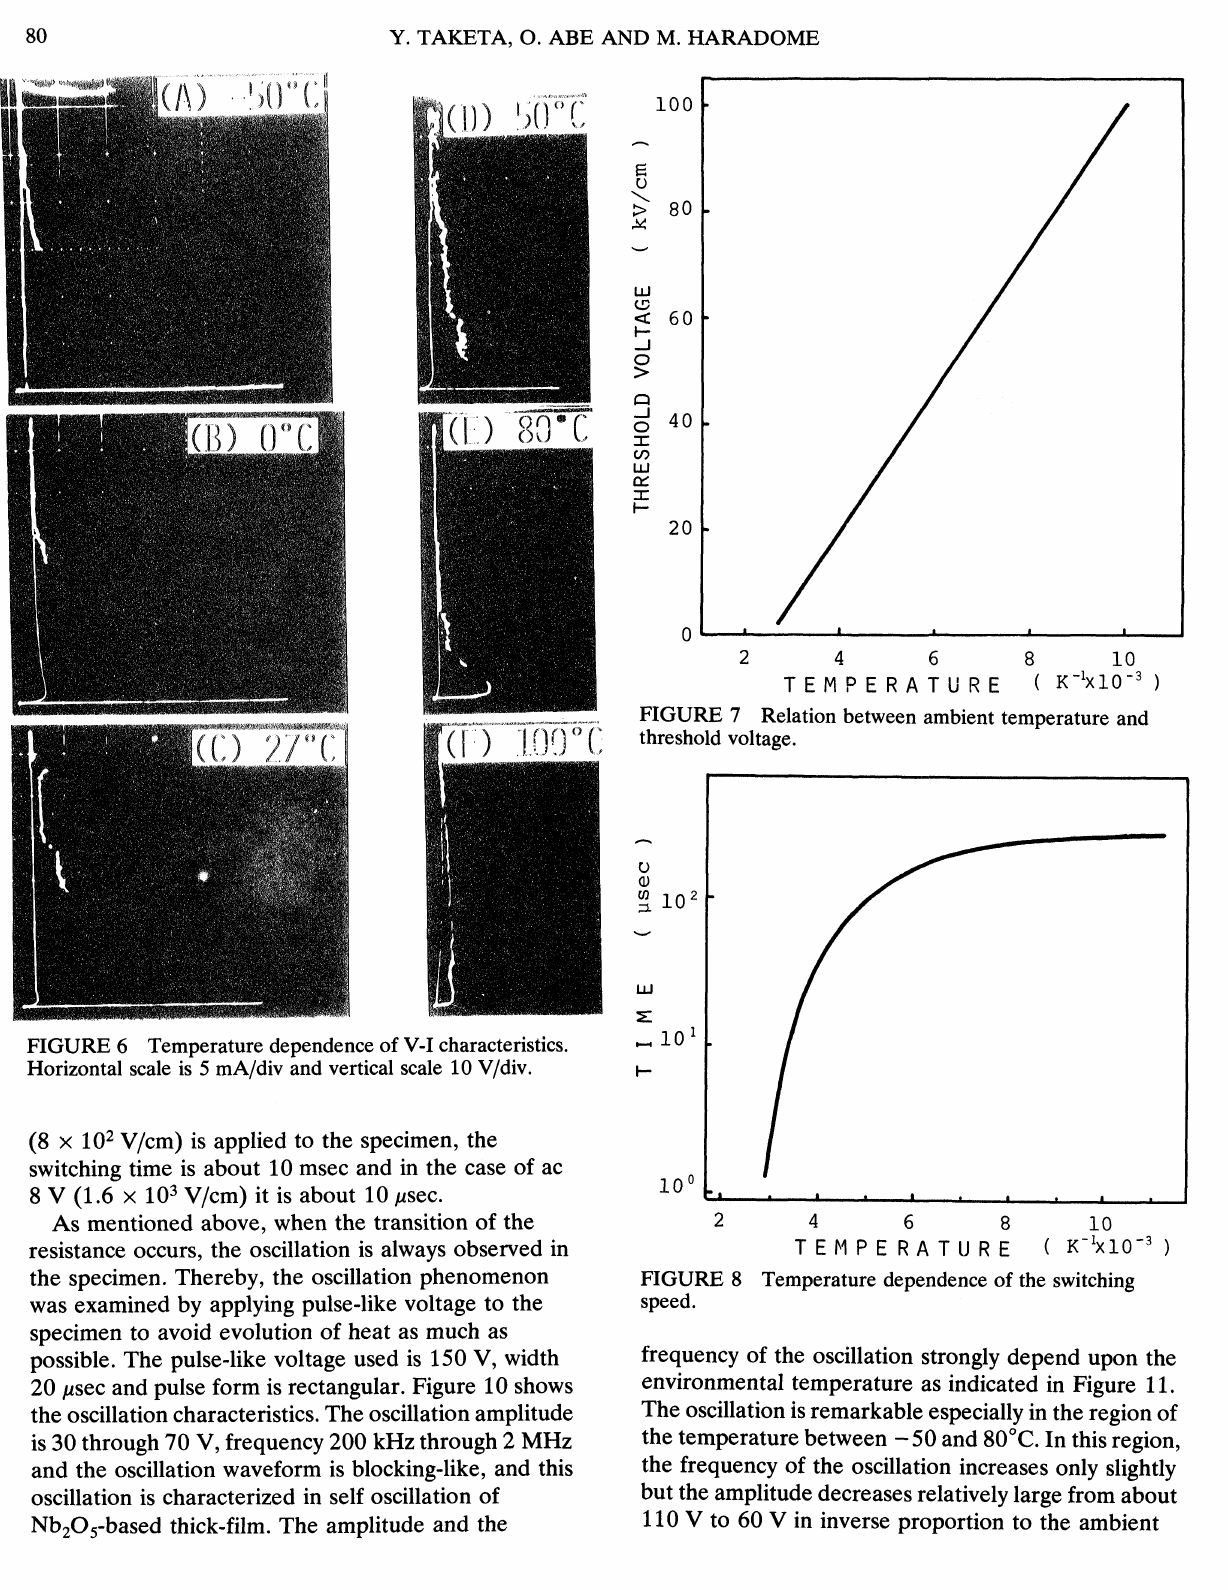
FIGURE 8 Temperature dependence of the switching